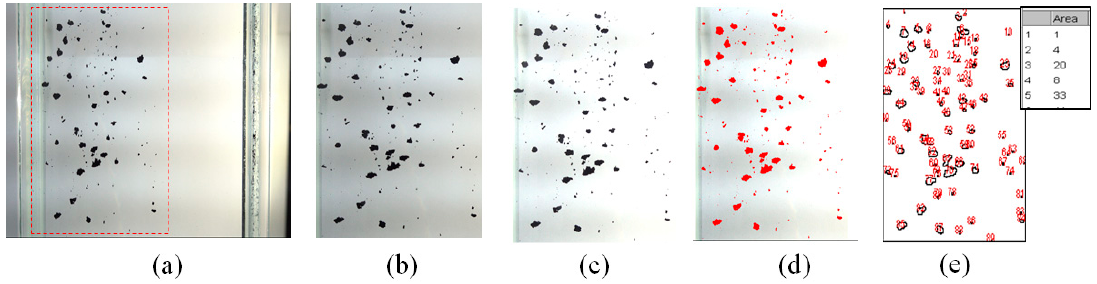
Figure 5. Image processing of CNT particle: ( a ) Original image; ( b ) enlarged image of captured part; ( c ) contrast processed image; ( d ) color thresholding processed image; ( e ) outlined processing. The obtained particle size from the imaging method shows wide distribution as in Figures 5 and 6.